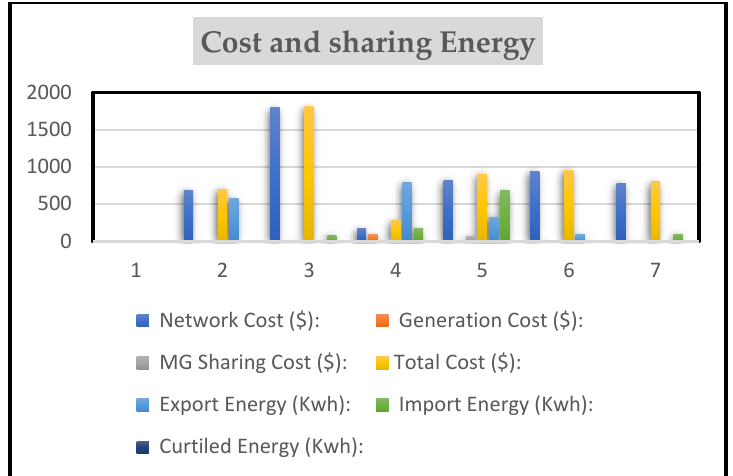
Figure 15. Case 2: total cost and energy-sharing.